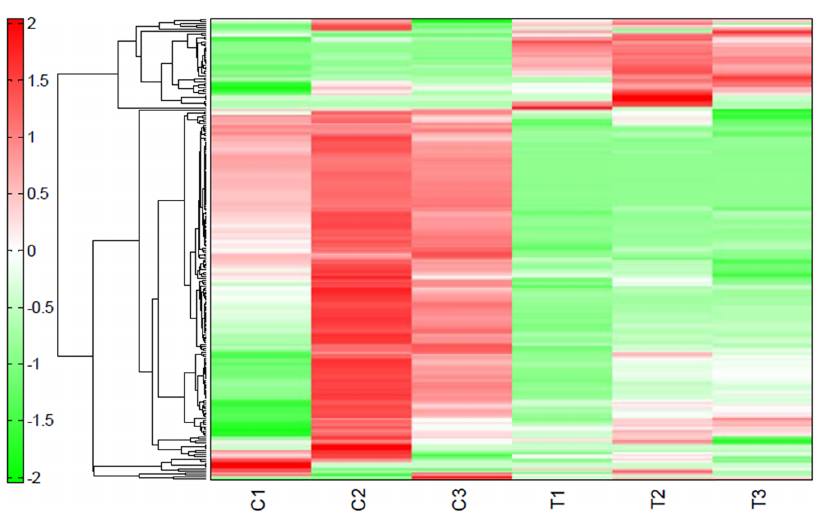
Fig 1. A heat map of hierarchical cluster analysis (HCA) comparing the altered metabolites between of O . japonicus fermented with L . plantarum and those of O . japonicus added with L . plantarum . The x- axis shows the controls (C1, C2, and C3) for the metabolites in O . japonicus added with L . plantarum and the treatments (T1, T2, and T3) for those in O . japonicus fermentedwith L . plantarum . The y-axis indicatesthe heat map for the changeof metabolites. The distances betweenpeaks are displayedin tree diagrams, and the degreesof red color and of green color indicatehigherand lower contents of the metabolites,